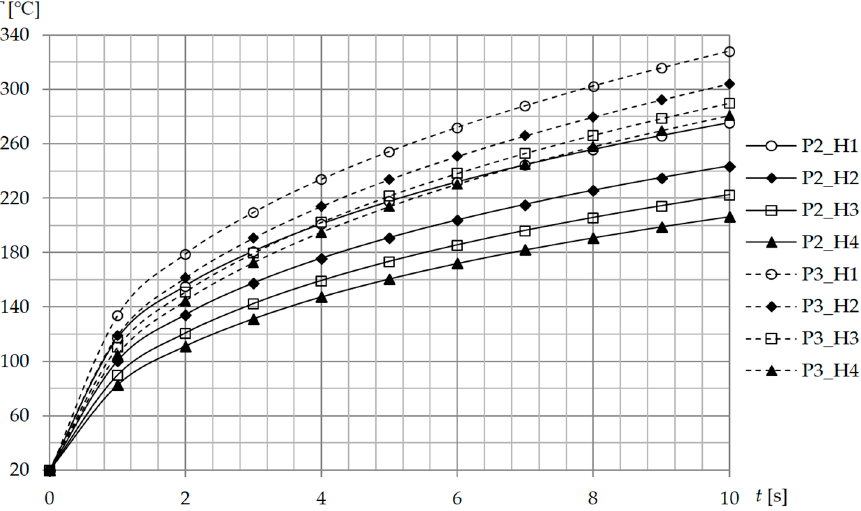
Figure 7. Temperature at point A (center of the cavity surface) in the function of time t for different geometries and distances between mold and inductor.